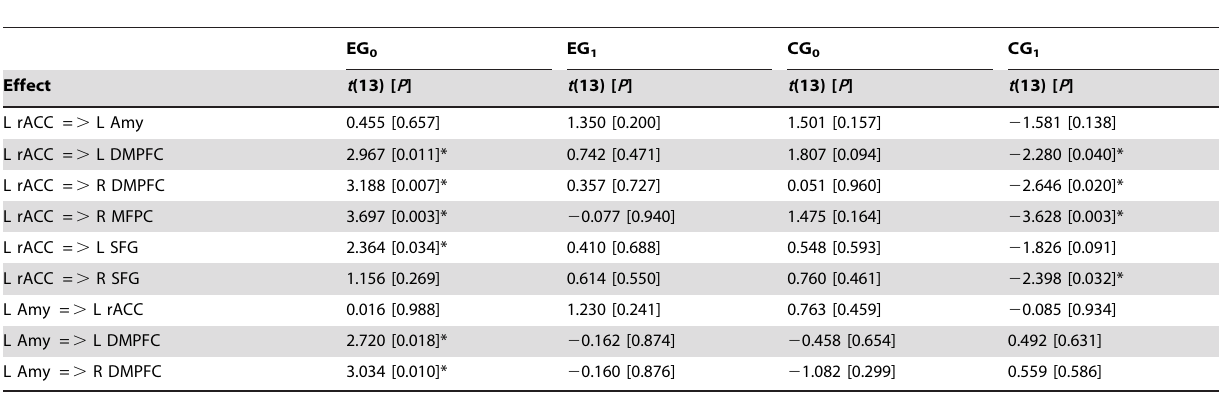
The table contains linear trend t -statistics for the SVAR path coefficients across the six experimental runs (RE…TR) with the corresponding group P -values. Each data row corresponds to a subplot in Fig. 6. Notations are the same as in Fig. 6. *indicate significant effect.